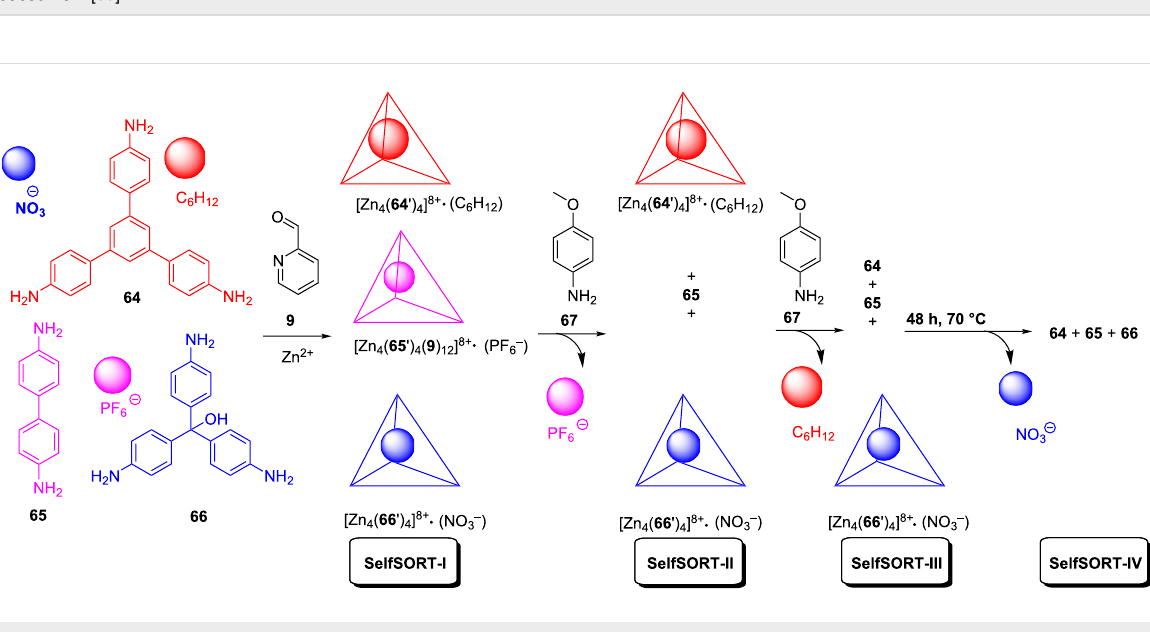
Whereas the organocatalyst 70 was firmly attached to the zinc porphyrin moiety of [Cu( 68 )] + , in [Cu( 68 )( 69 )] + it was expelled into solution unfolding its catalytic activity in a Knoevenagel addition reaction. At the same time, the click reaction